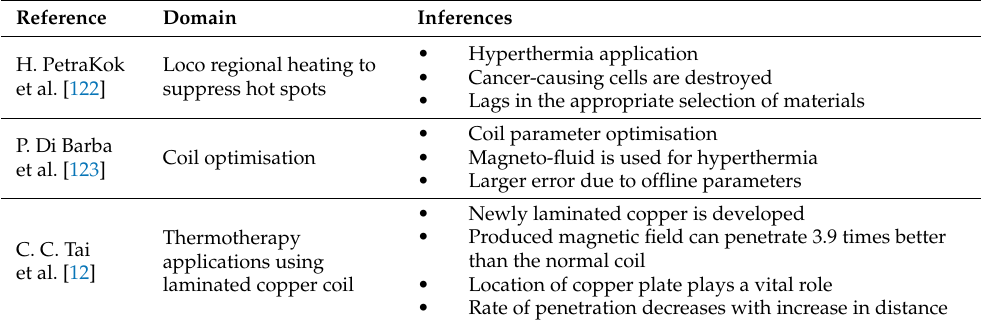
Table 8. Recent researches connected to IH in medical